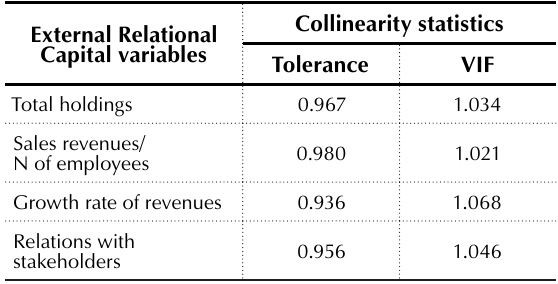
Table 5. Collinearity diagnosis on ERC variables